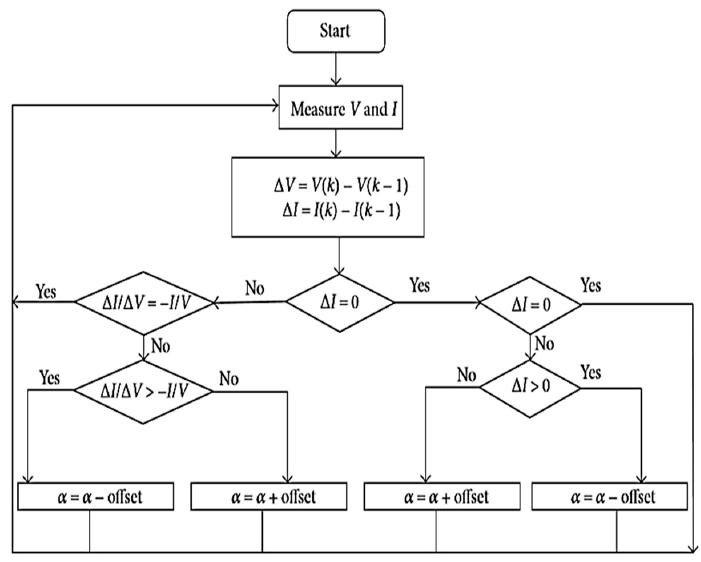
Figure 8. Incremental conductance flowchart.